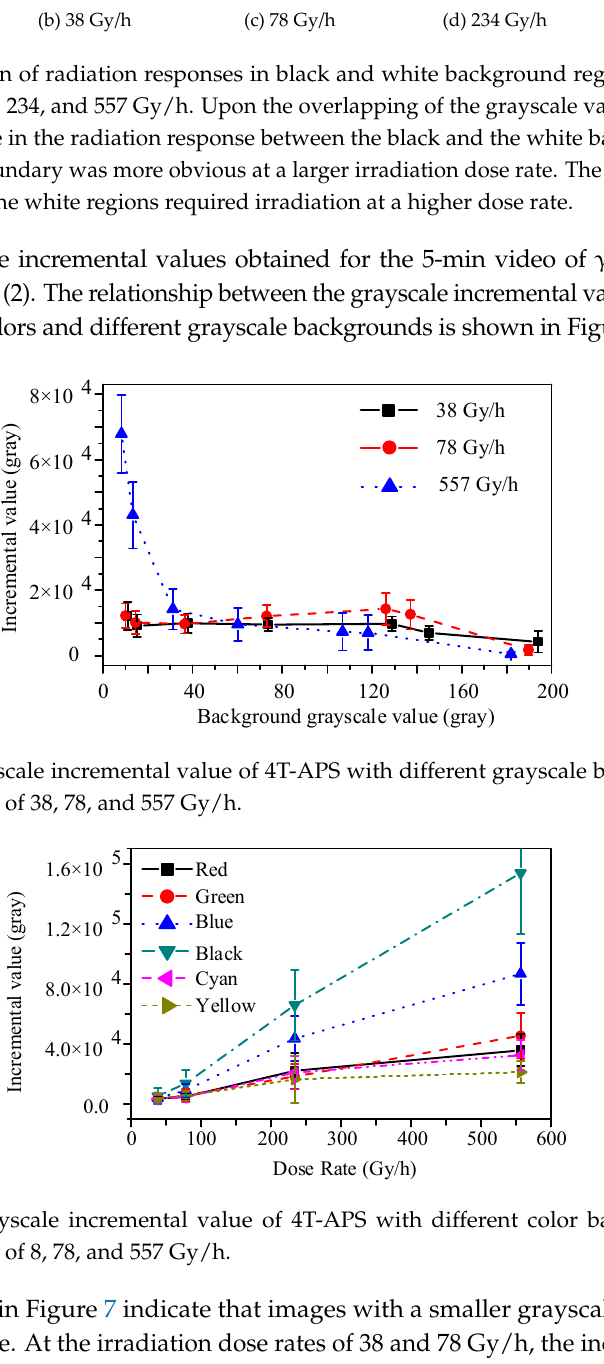
Figure 6. Comparison of radiation responses in black and white background regions at irradiation dose rates of 0, 38, 78, 234, and 557 Gy/h. Upon the overlapping of the grayscale value of 2000 frames, an obvious difference in the radiation response between the black and the white background regions was observed; the boundary was more obvious at a larger irradiation dose rate. The radiation response events generated in the white regions required irradiation at a higher dose rate.